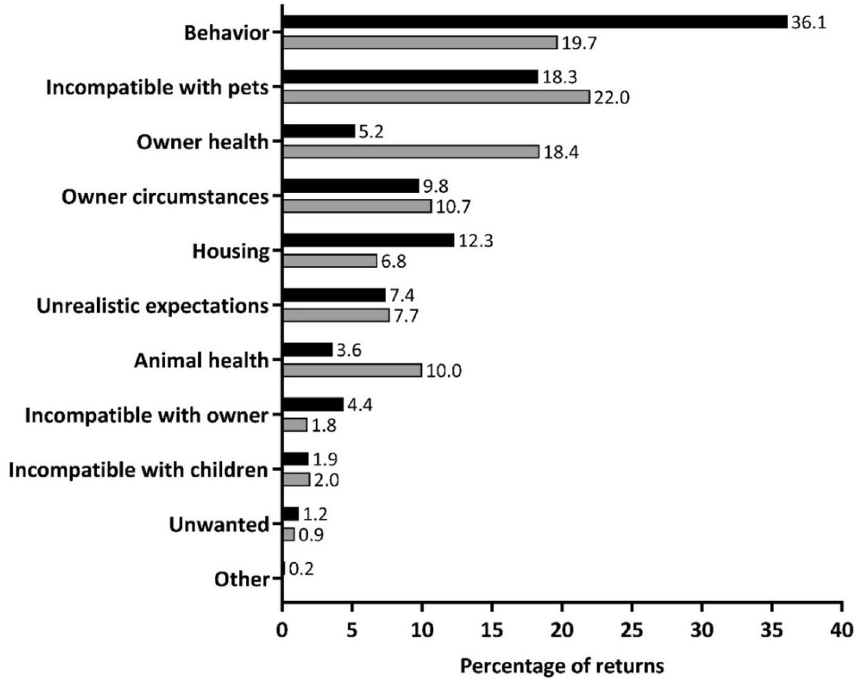
Figure 1. Categorized reasons for returns, including the first return for animals that were returned multiple times. Black bars represent dogs ( n = 1627) and grey bars represent cats ( n =